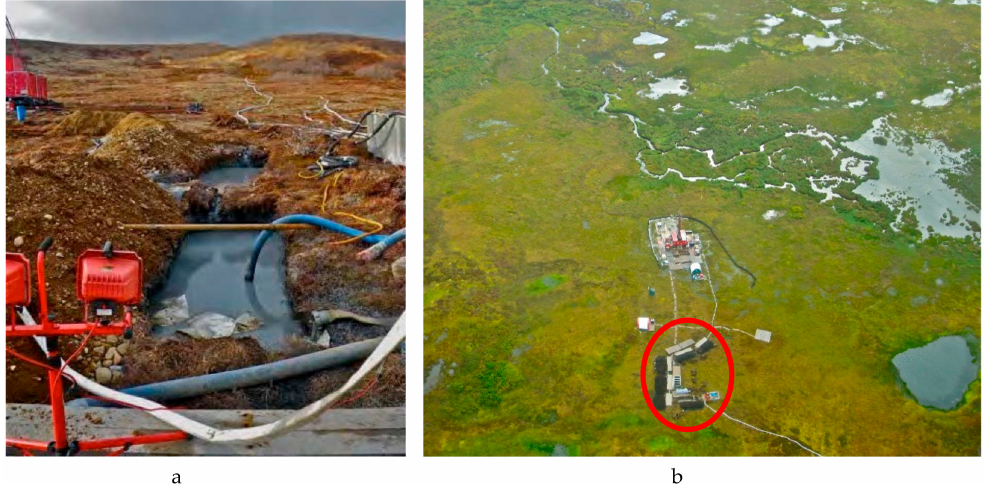
Figure 8. Drill waste sumps. ( a ) Drill waste sumps. ( b ) Drilling at site 11540 in 2011. Red circle indicates location of drill waste sumps. Photo credit: M. Welker, R.